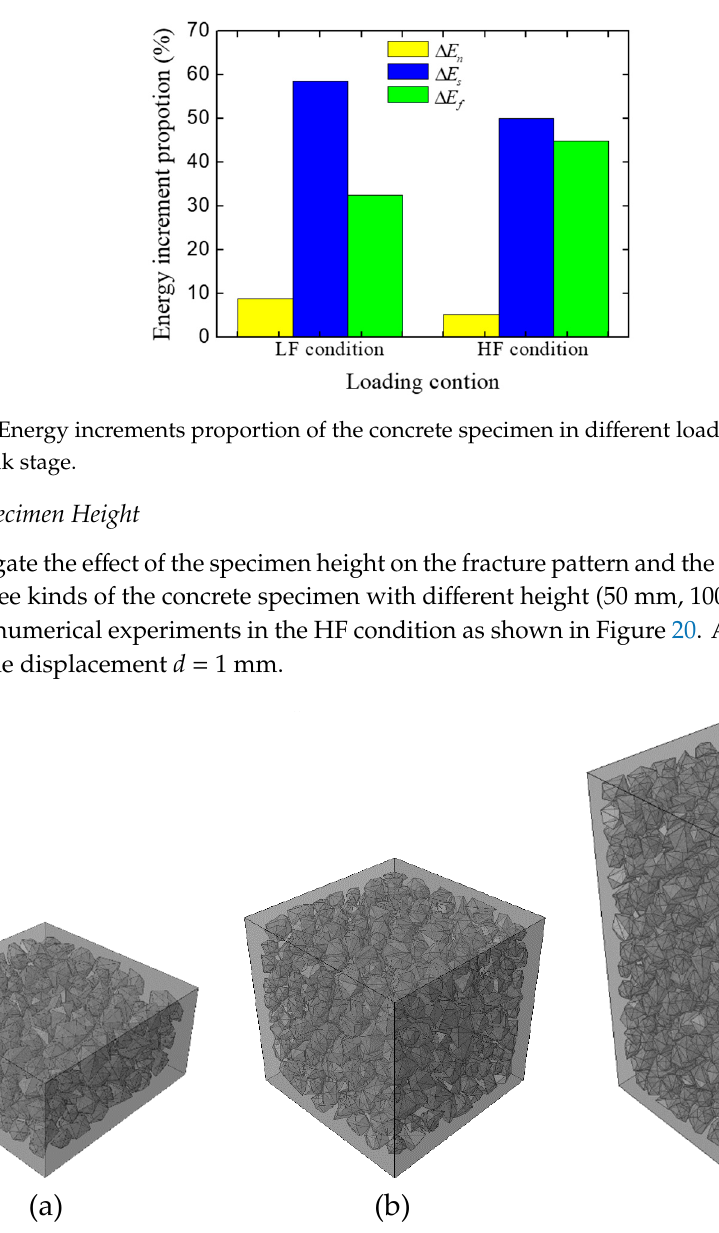
Figure 20. Concrete specimens with the different heights: ( a ) 50 mm, ( b ) 100 mm, ( c ) 200 mm.